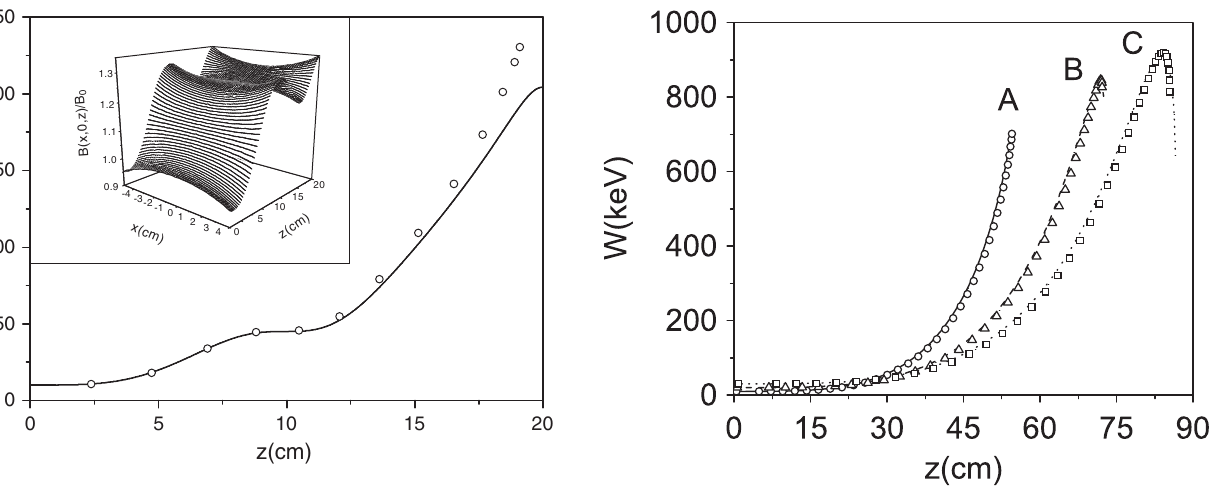
FIG. 7. Energy evolution in a linear magnetic field at different